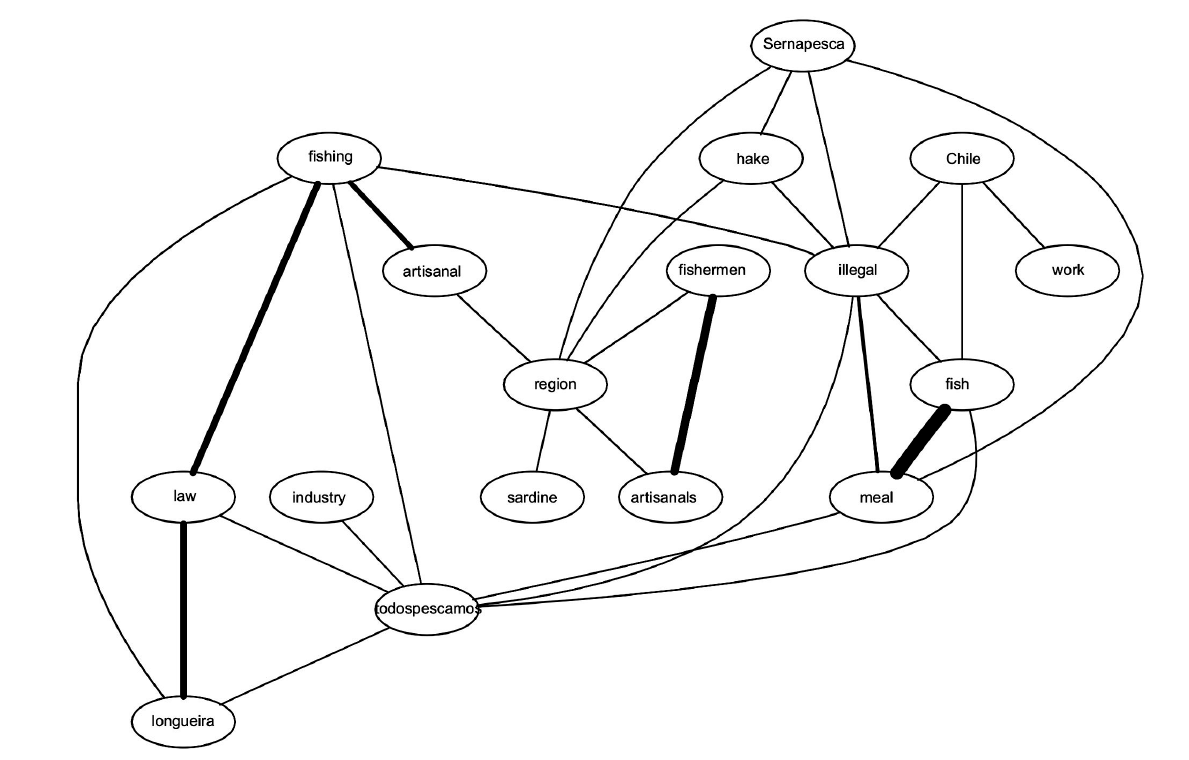
Fig. 3 . Main communication topics before the crisis: March 2013 to February